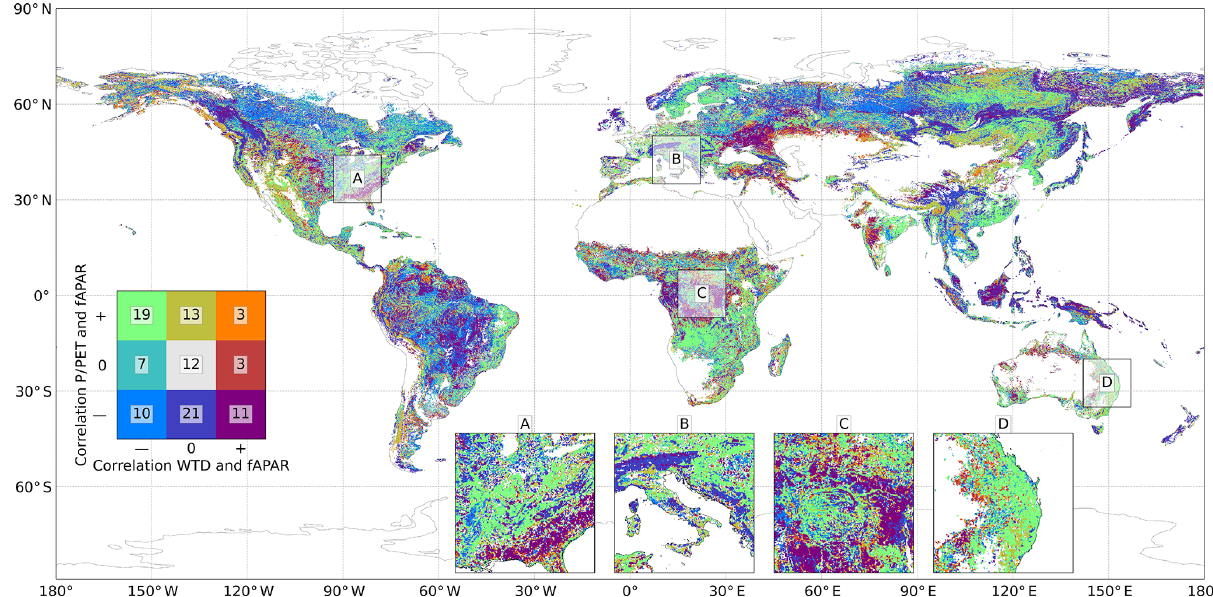
Figure 3. Global distribution of ecohydrological classes. The legend indicates the percentage of grid cells in the different classes. The map is downsampled to a resolution of 5arcmin. For a bigger version of the map, see Fig. S17. Note that the percentages add up to 99, which is caused by